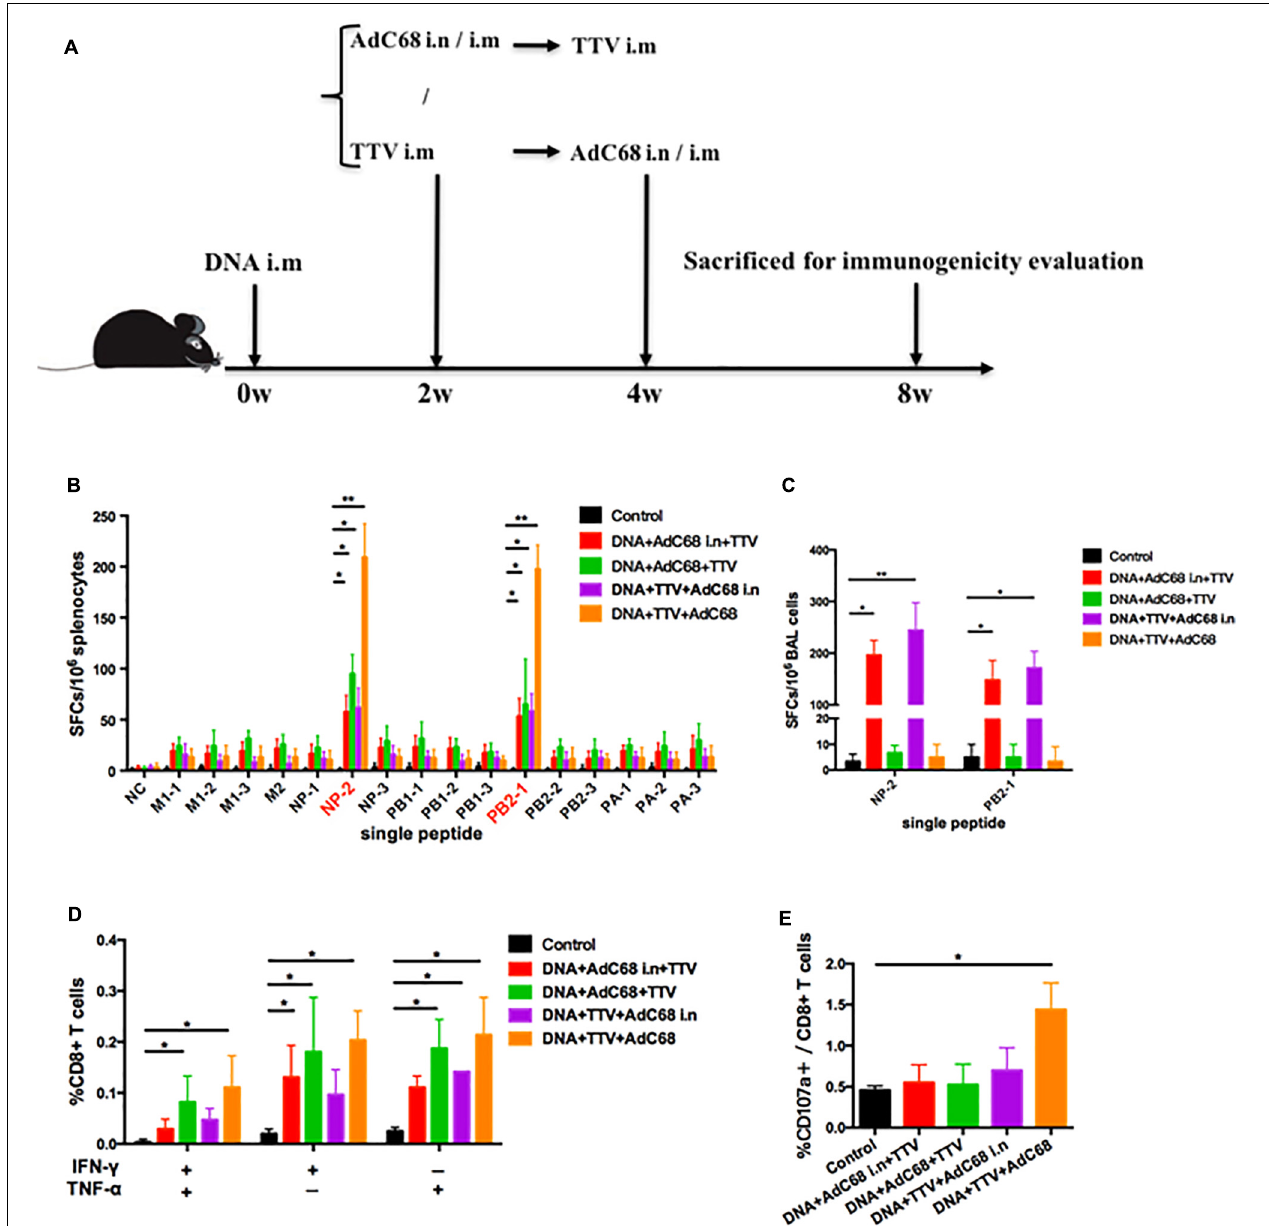
FIGURE 4 | Intranasal administration of AdC68 elicits significantly more potent respiratory residential and less systemic memory T cell responses. (A) Schematic illustration of immunization regimens. Control group were immunized with one dose of control pSV1.0 vector (100 ug) via intramuscular (i.m) route and two doses of control AdC68 empty vector (1 × 10 11 vp) separately via intramuscular (i.m) and intranasal (i.n.) route. Experimental groups were sequentially immunized with DNA, AdC68, and TTV in the indicated order, the intramuscular route was treated as default to be left undenoted whereas the intranasal administration was labeled as i.n. Splenocytes and bronchoalveolar lavage (BAL) were isolated 4 weeks after vaccination for measurement of influenza-specific immune responses. (B) IFN γ ELISpot assay of splenocytes in response to stimulation with a single indicated influenza-specific epitope peptide. (C) IFN γ ELISpot assay of BAL in response to stimulation with NP-1 and PB2-1 peptides. (D,E) Intracellular cytokine staining assay to determine the percentage of CD8+ splenocytes secreting IFN- γ , TNF- α , or both, and CD107a-positive cells after stimulation with the peptide pool. All determinations were carried out in triplicate and the error bars represent the SDs. ∗∗ p < 0.01; ∗ p < 0.05, t